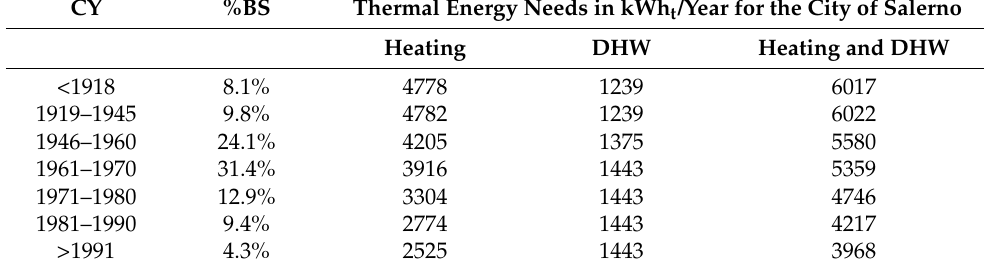
Table 2. Thermal energy needs for space heating and DHW preparation per construction year CY for the city of Salerno and portion of the building stock